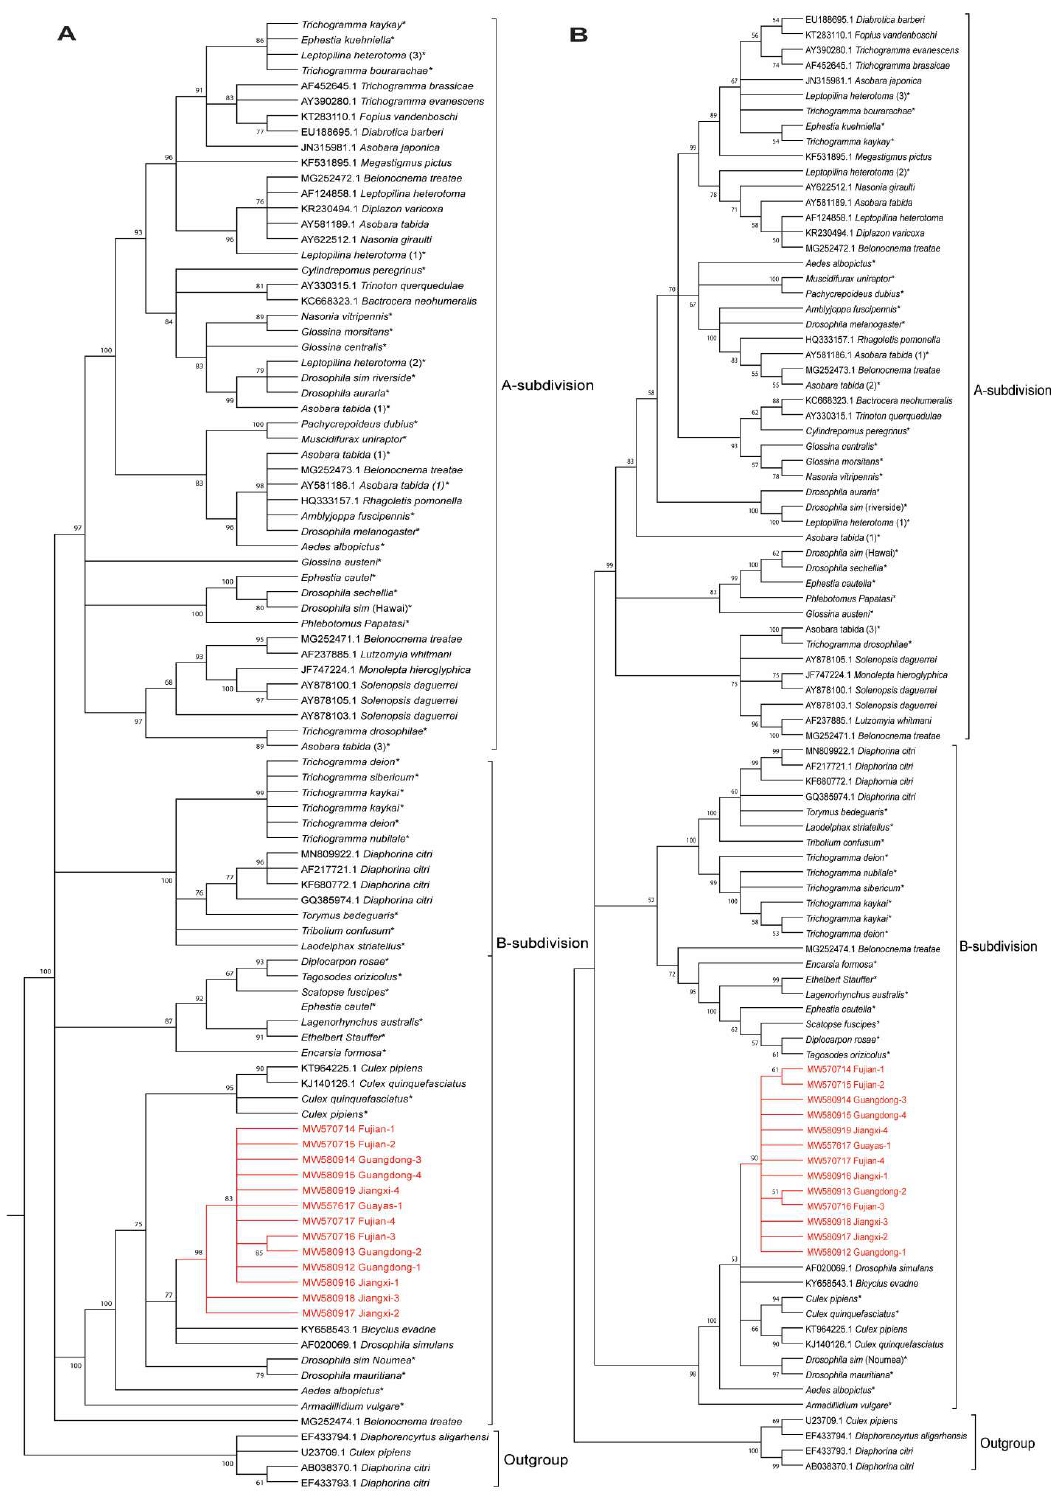
Figure 4. Phylogeny of wsp gene from Wolbachia associated with different insect species, including Tamarixia radiata from this study. ( A ) The phylogenetic tree was constructed through the Maximum Likelihood method. ( B ) The phylogenetic tree was constructed through the Neighbour-Joining method by the Maximum Composite Likelihood model. All wsp sequences of Wolbachia obtained in the study are highlighted in red lines and font. For tree construction, wsp gene sequences were collected from the NCBI database for tree construction, representing different insect species and host–parasitoid relationships. The four sequences of 16s RNA were chosen as an outgroup. For tree construction, the bootstrap value was replicated 1000 times. The sequence represented by * is taken from Vavre et al.,